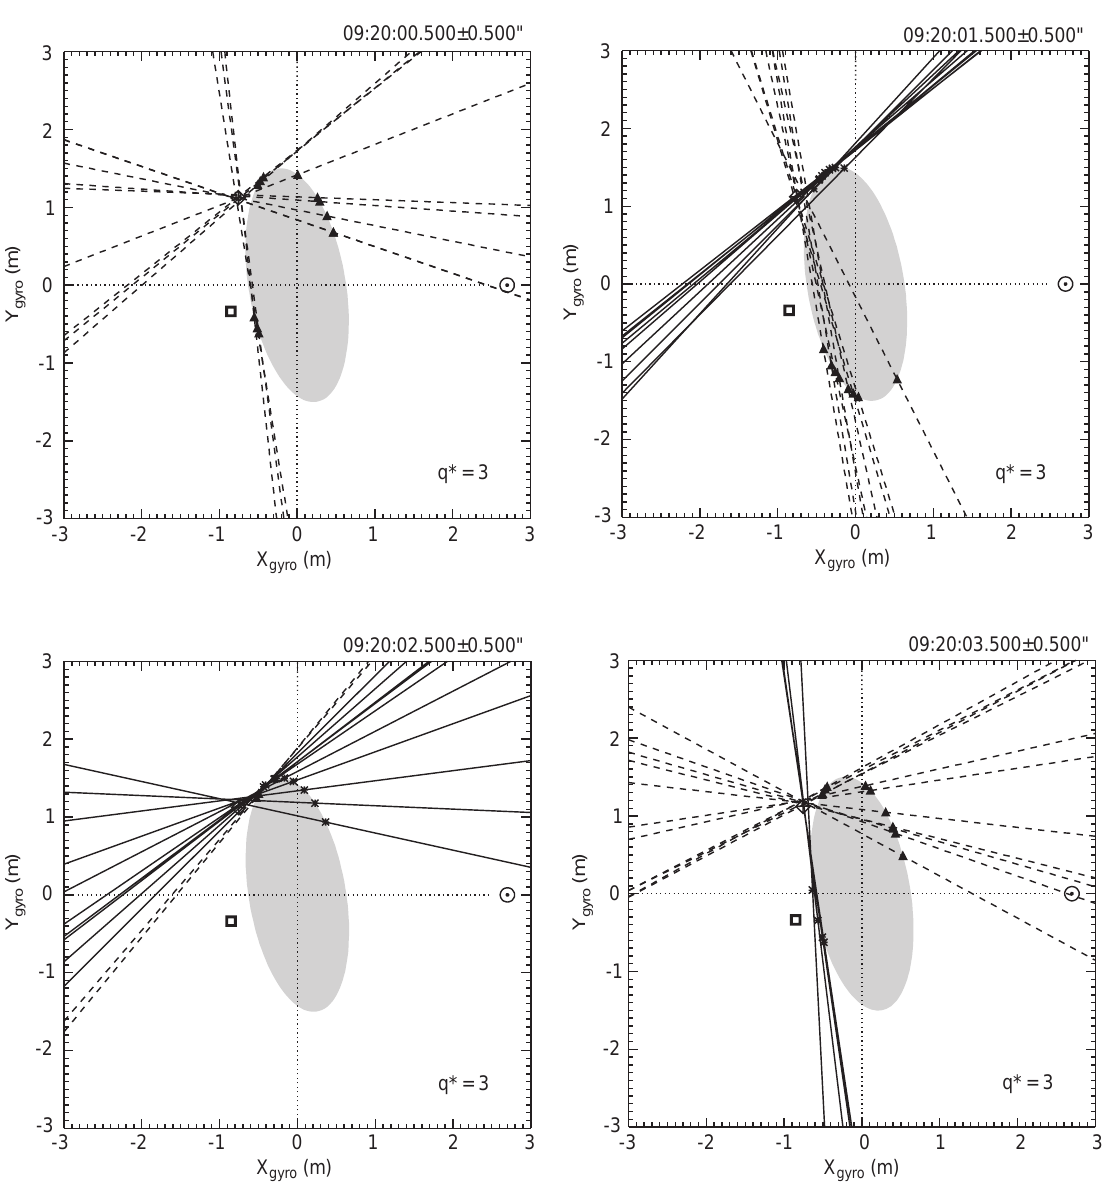
position crossed-diamond symbol , determines the tail of the drift-step vector, as indicated in Fig. 1. For comparison, the drift due to the spacecraft velocity over one gyro period is marked by the square in the lower left